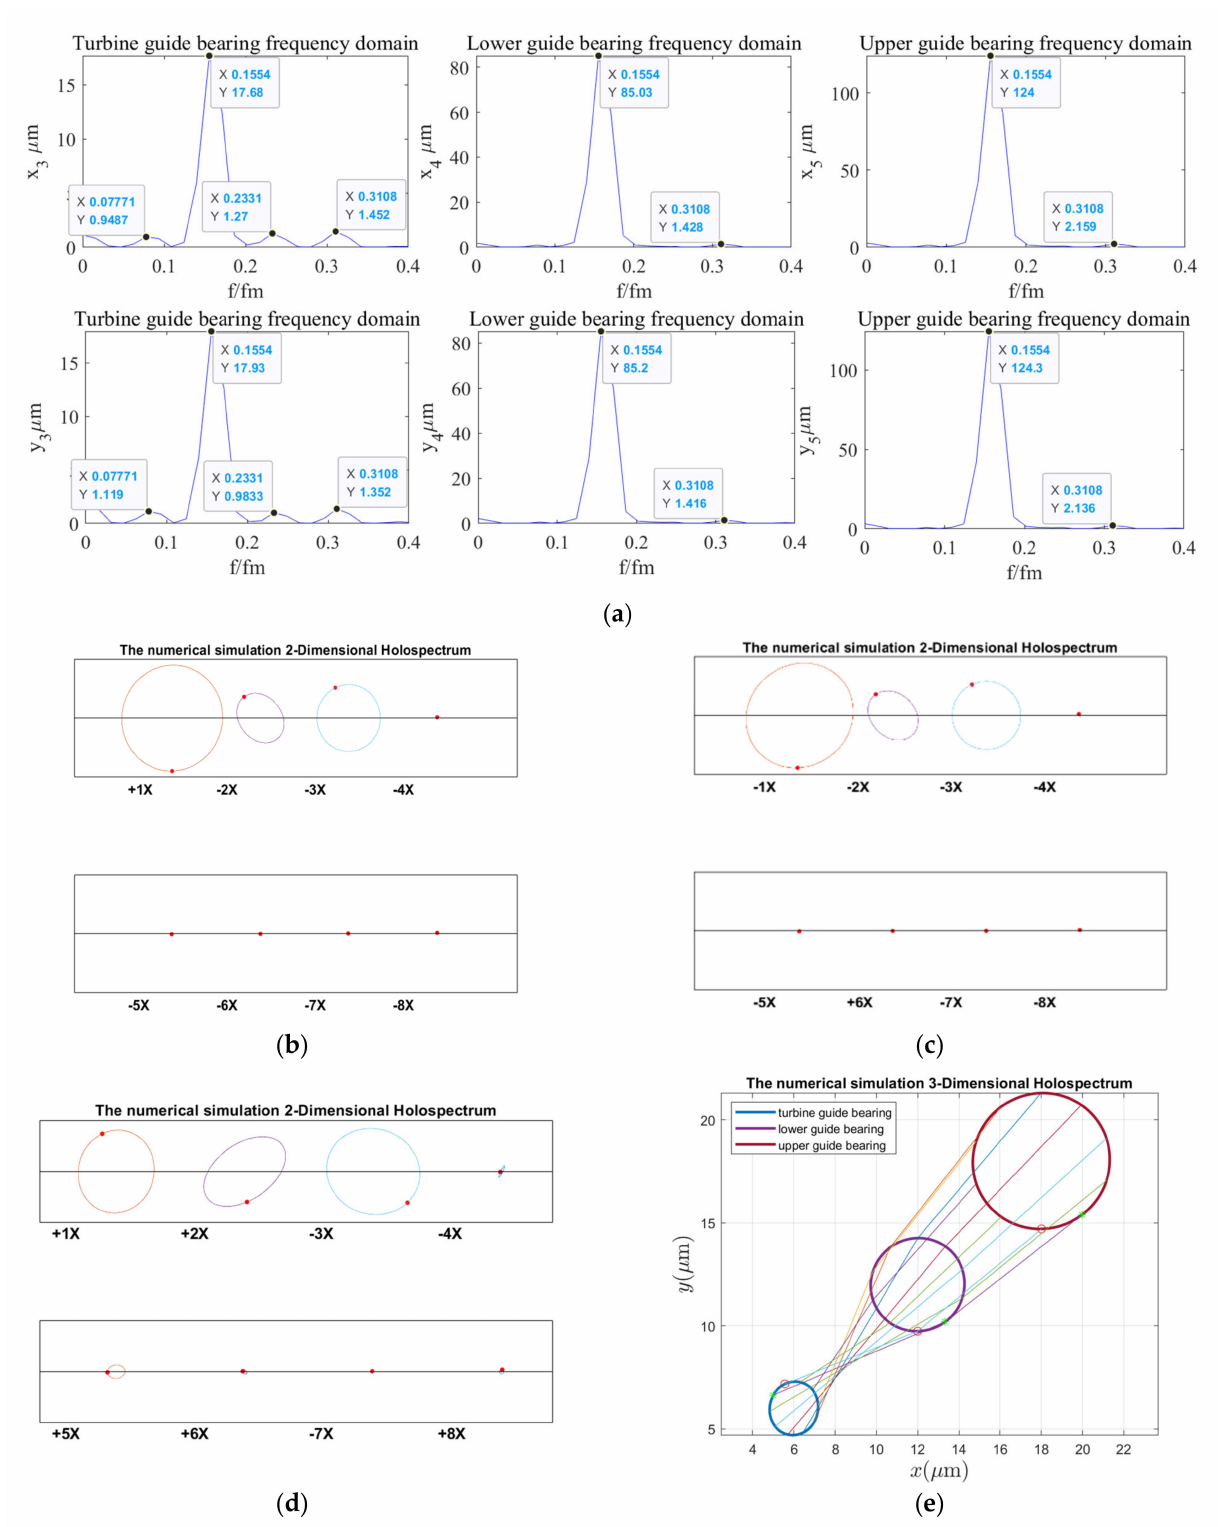
Figure 19. Holospectrum of shafting vibration of misaligned unbalance rotor, considering the oil film, RAW, rub, UMP, turbine runner vortex eccentricity, and hydraulic imbalance forces: ( a ) Shafting vi- bration spectrogram, ( b ) Upper guide bearing 2D holospectrum, ( c ) Lower guide bearing 2D holospec- trum, ( d ) Hydro-turbine guide bearing 2D holospectrum, ( e ) One-fold frequency 3D